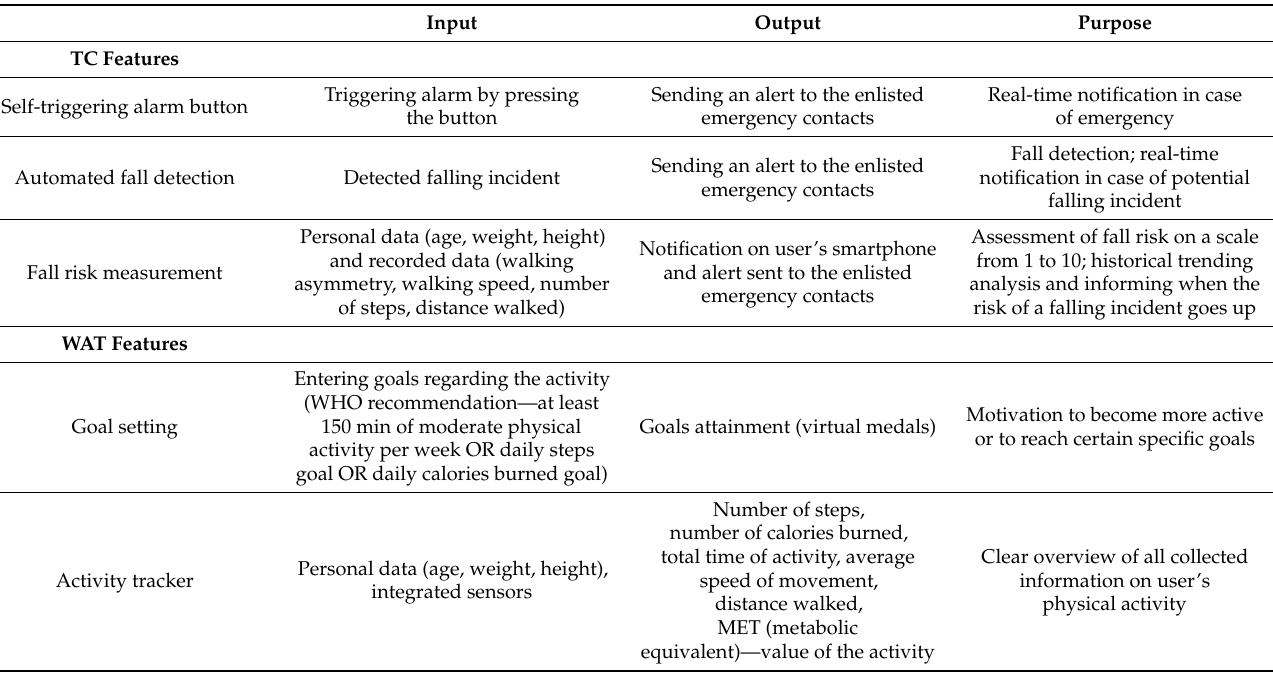
Table 2. Summary of services supported by the tested